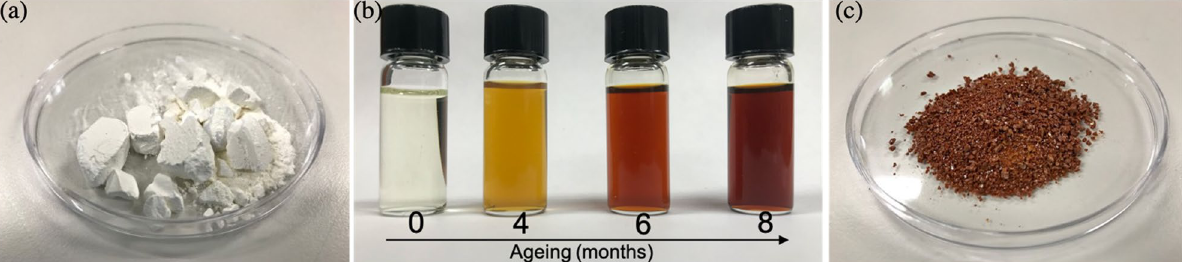
Figure 1. Amorphous TiO 2 nanoparticles obtained by sol–gel technique. ( a ) White TiO 2 powder synthesized trough a standard sol–gel reaction. ( b ) Ageing of the solution used to produce oxygen vacancy-rich (red)